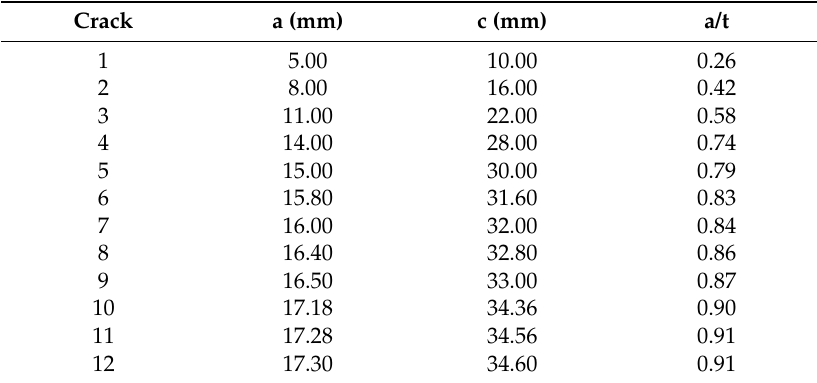
Table 1. Variation of crack dimensions.